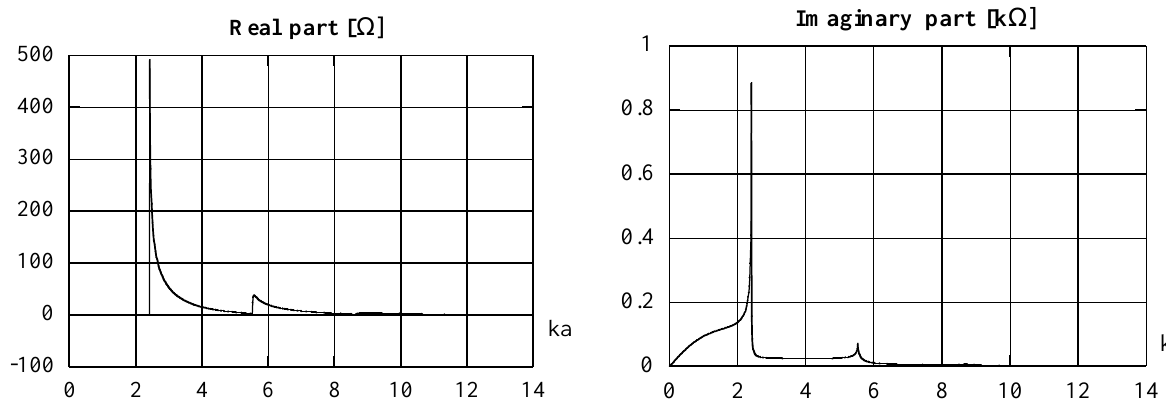
FIG. 9. Real and imaginary parts of the longitudinal coupling impedance in the case (cid:119) (cid:173) (cid:49) (cid:121) (cid:53) and bg (cid:173) (cid:49) .